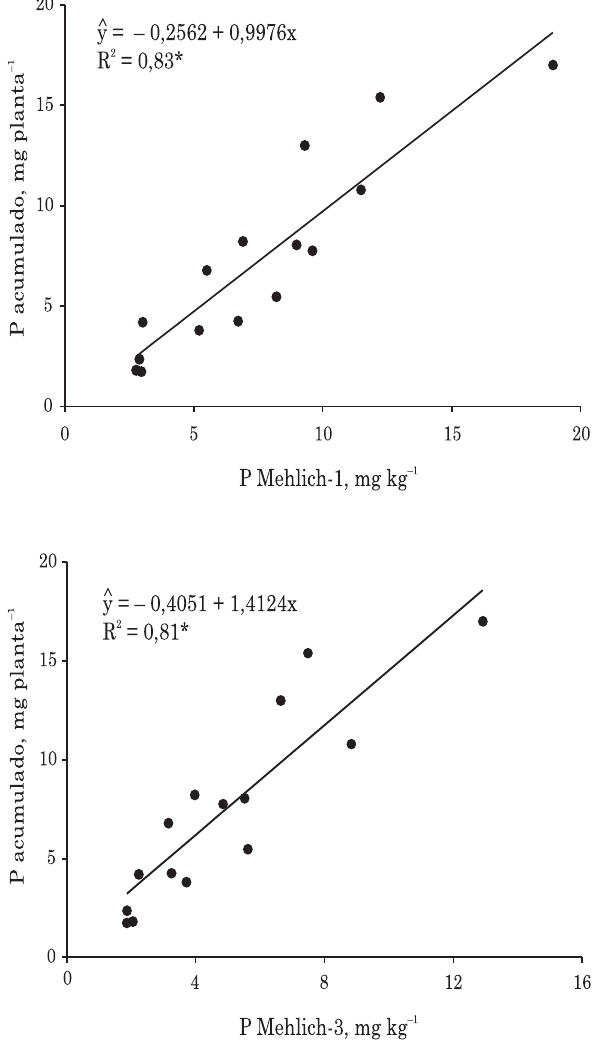
Figura 1. Relação entre os teores de fósforo extraídos pelo Mehlich-1 e Mehlich-3 e as quantidades de fósforo acumulado pelo arroz nas amostras dos solos: Planossolo, Gleissolo, Luvissolo, Vertissolo e Chernossolo, nas três doses de fósforo (0; 19,65 e 39,3 mg kg -1 de P no